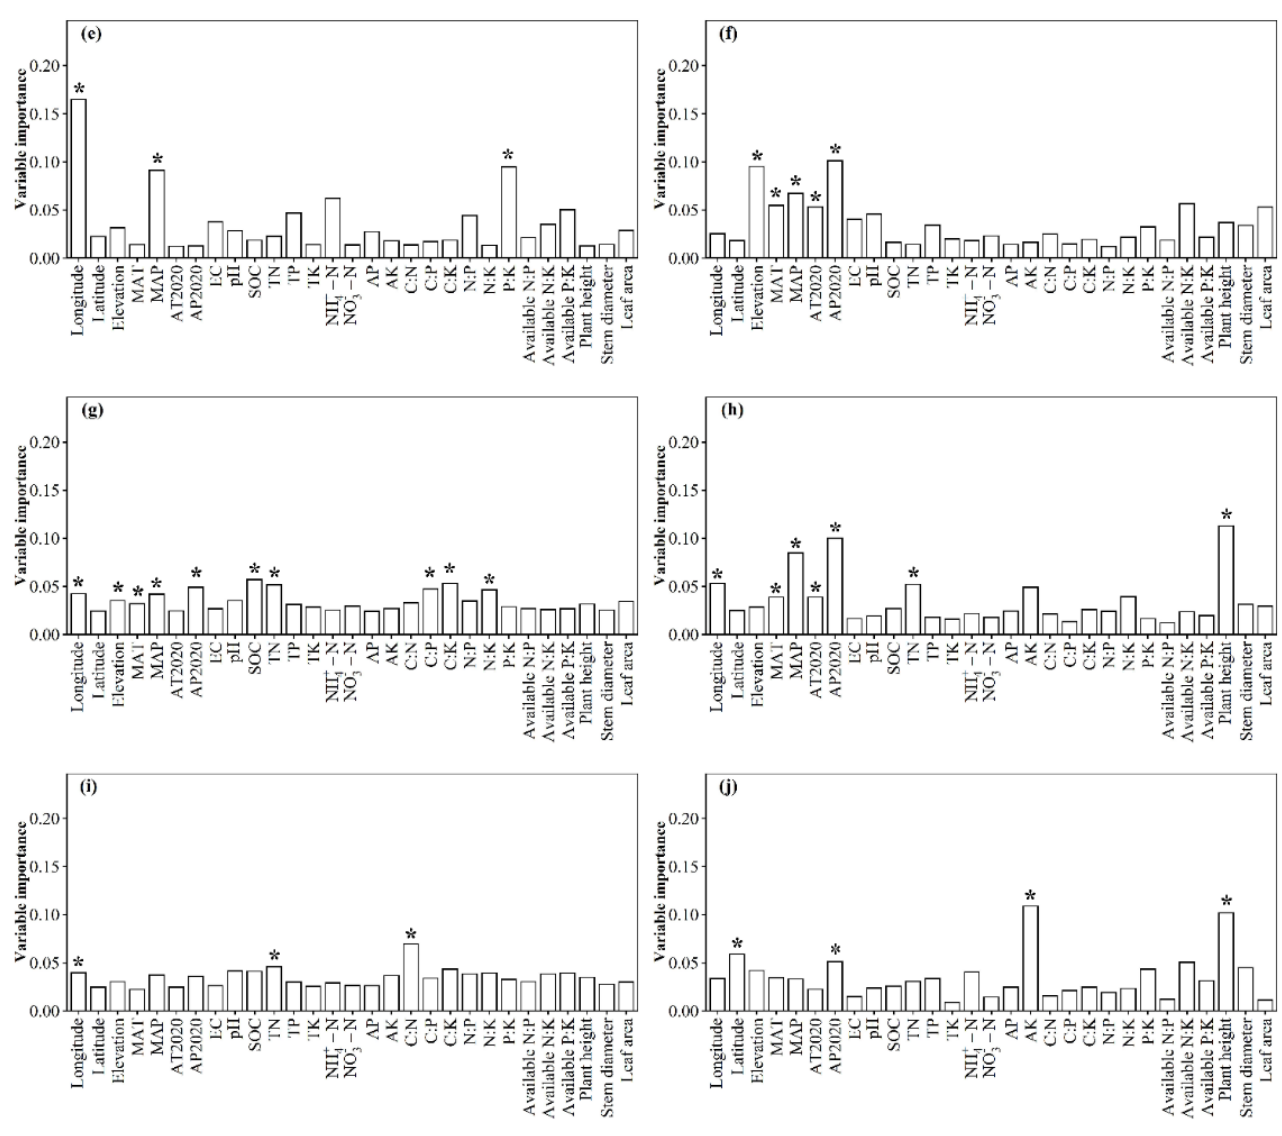
Figure 2. Relative impacts of environmental variables on ( a , b ) operational taxonomic units (OTU s ), ( c , d ) Chao1 s , ( e , f ) ACE s , ( g , h ) Shannon s and ( i , j ) Simpson s for ( a , c , e , g , i ) topsoil and ( b , d , f , h , j ) sub-